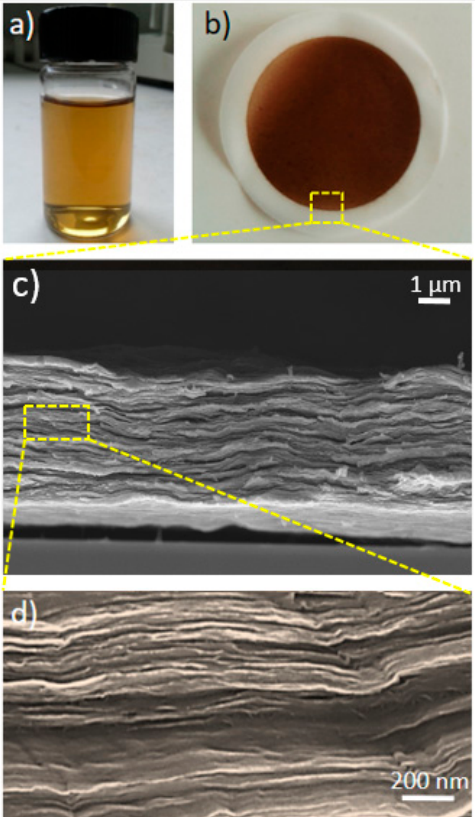
Figure 2. ( a ) GO dispersion in water. ( b ) GO membrane on polycarbonate track etched (PCTE) support. ( c ) FESEM image showing a cross-section of a self-standing GO membrane without polymeric support. ( d ) Higher FESEM magnification showing the layered ordered structure of such